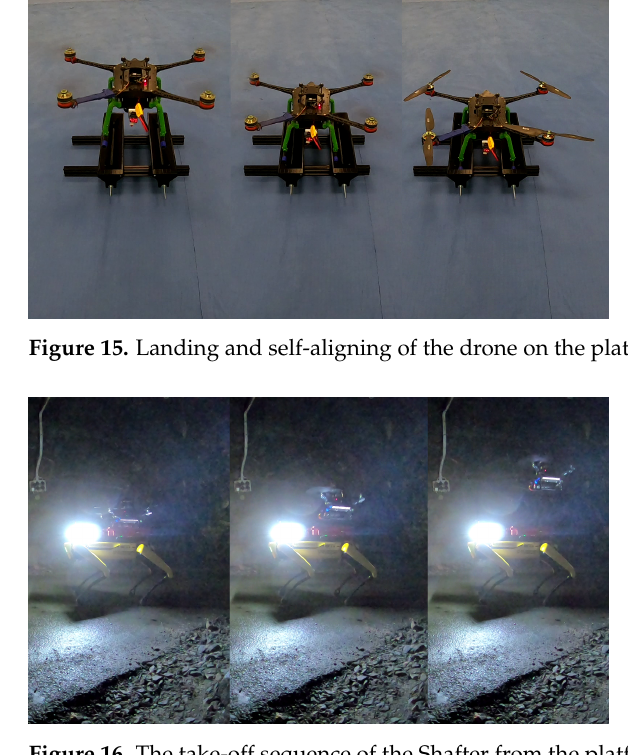
Figure 16. The take-off sequence of the Shafter from the platform during the field tests.